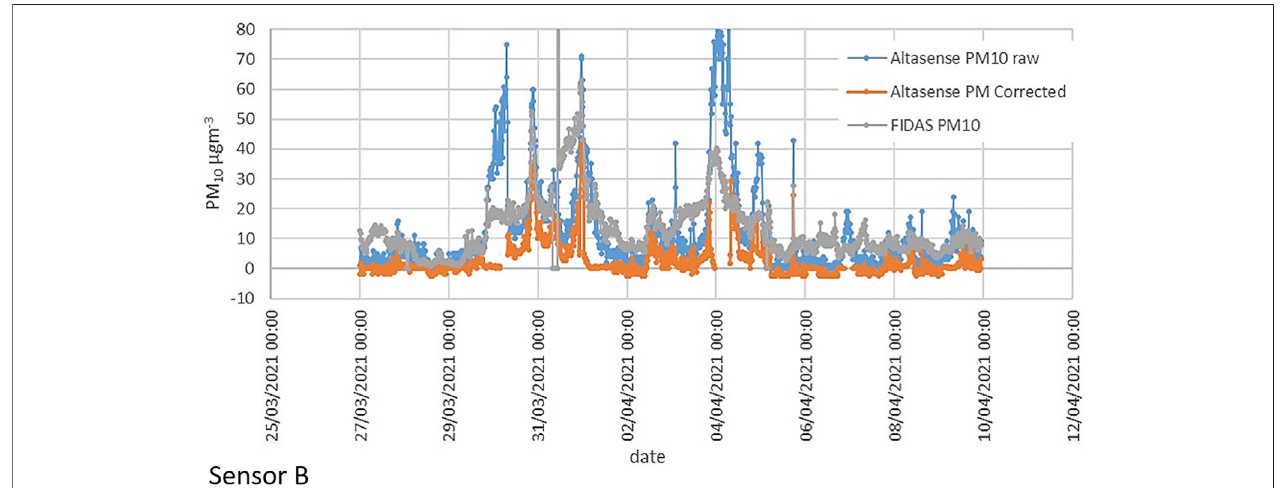
FIGURE 8 | Example of over-correction when using the K-Köhler method stated above for one of the Altasense PM units for PM 10 concentrations.